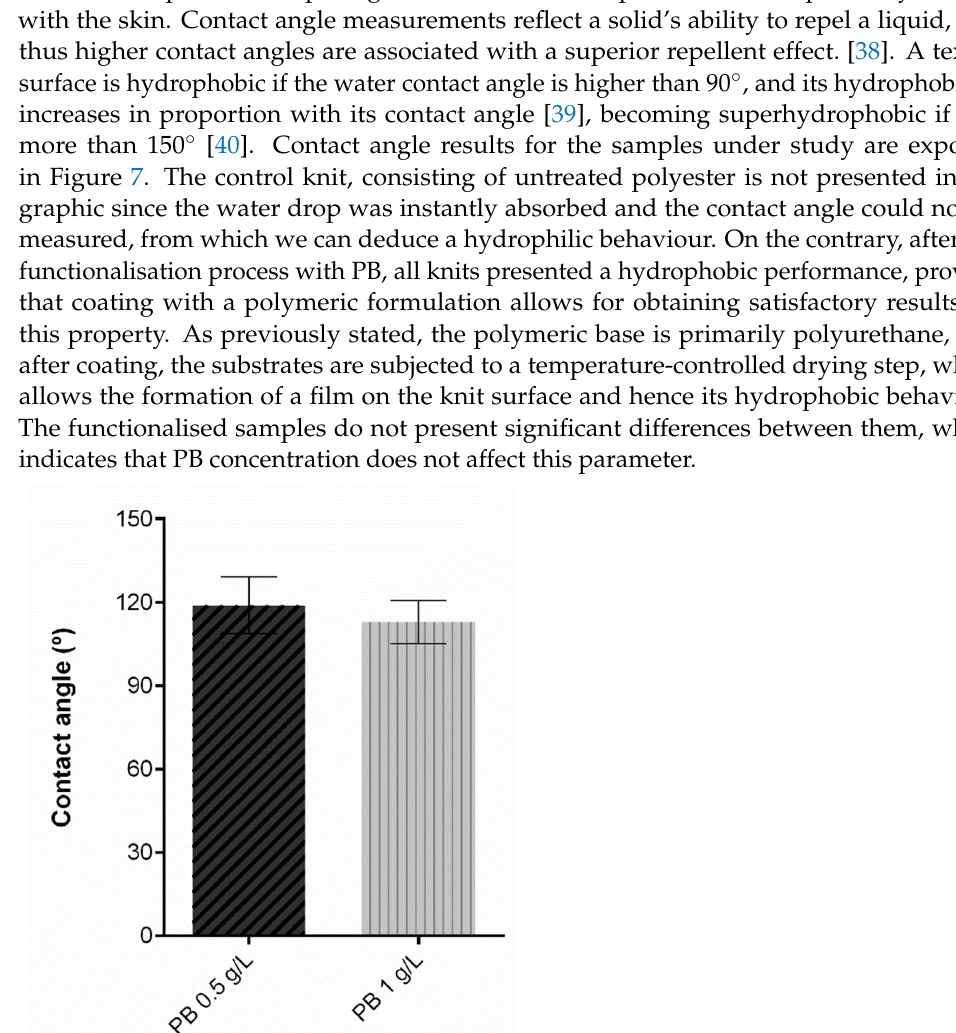
1 g/L were analysed, since they were the ones that showed bacterial-sensing potential. The level of performance is subsequently evaluated according to the above-mentioned criteria in Table 1. For the acid agent, the results seen in Table 4 show a low penetration index and a high repellence efficiency, with the sample PB 0.5 g/L displaying level 3 performance for both measurements. For PB 1 g/L the performance level for penetration is classified as 2, however, the index percentage is near the threshold value (1%). For the repellence index, the percentage obtained was above 100, which was not expected since the fibrous surface cannot repel more solution than what is poured on top of it. This could be explained by a small degradation/corrosion of the fibres, caused by the sulfuric acid at high concentra- tion. Under optimal conditions of temperature, time and concentration this acid is fre- quently used in the hydrolysis of polyester structures [41,42], which indicates the poten- tial of this chemical to degrade this material.